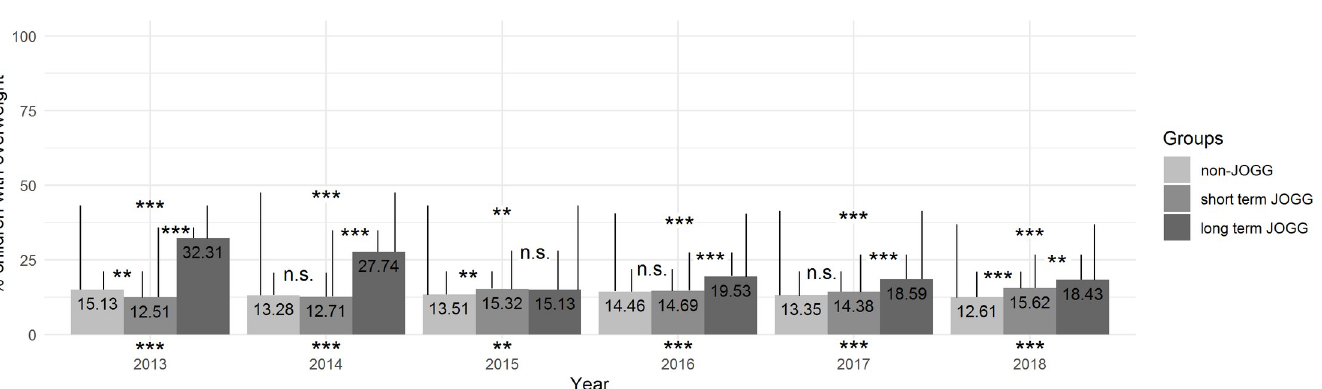
PLOS ONE | https://doi.org/10.1371/journal.pone.0261406 December17,